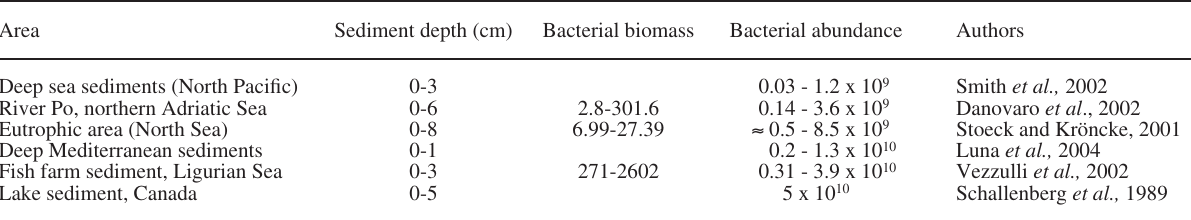
Table 4. – comparison of bacterial biomass (µg c g -1 ) and abundance (cells g -1 ) from different